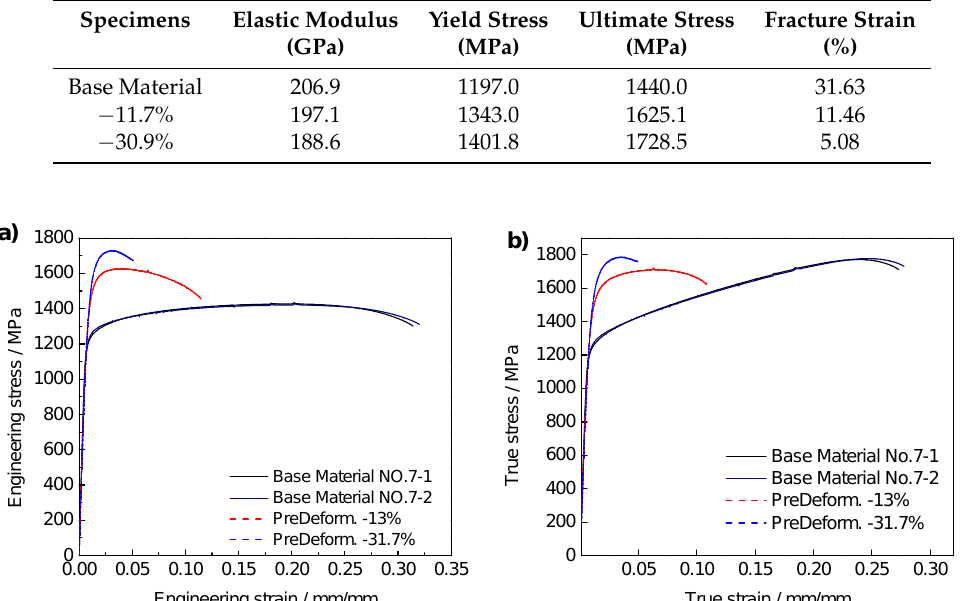
Table 2. Static mechanical property (Engineering Stress–Strain) of the IN718 base material and pre-deformed material.